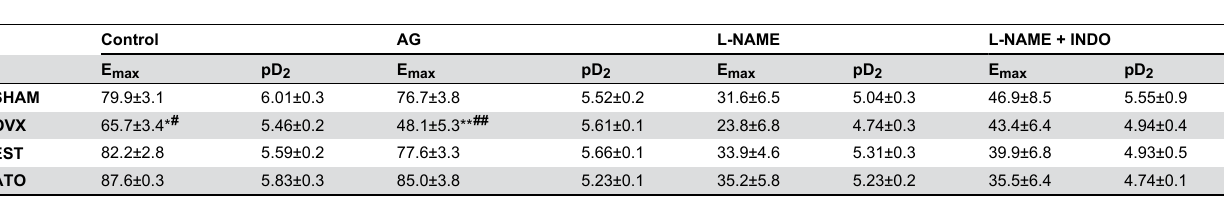
) and sensitivity (pD max